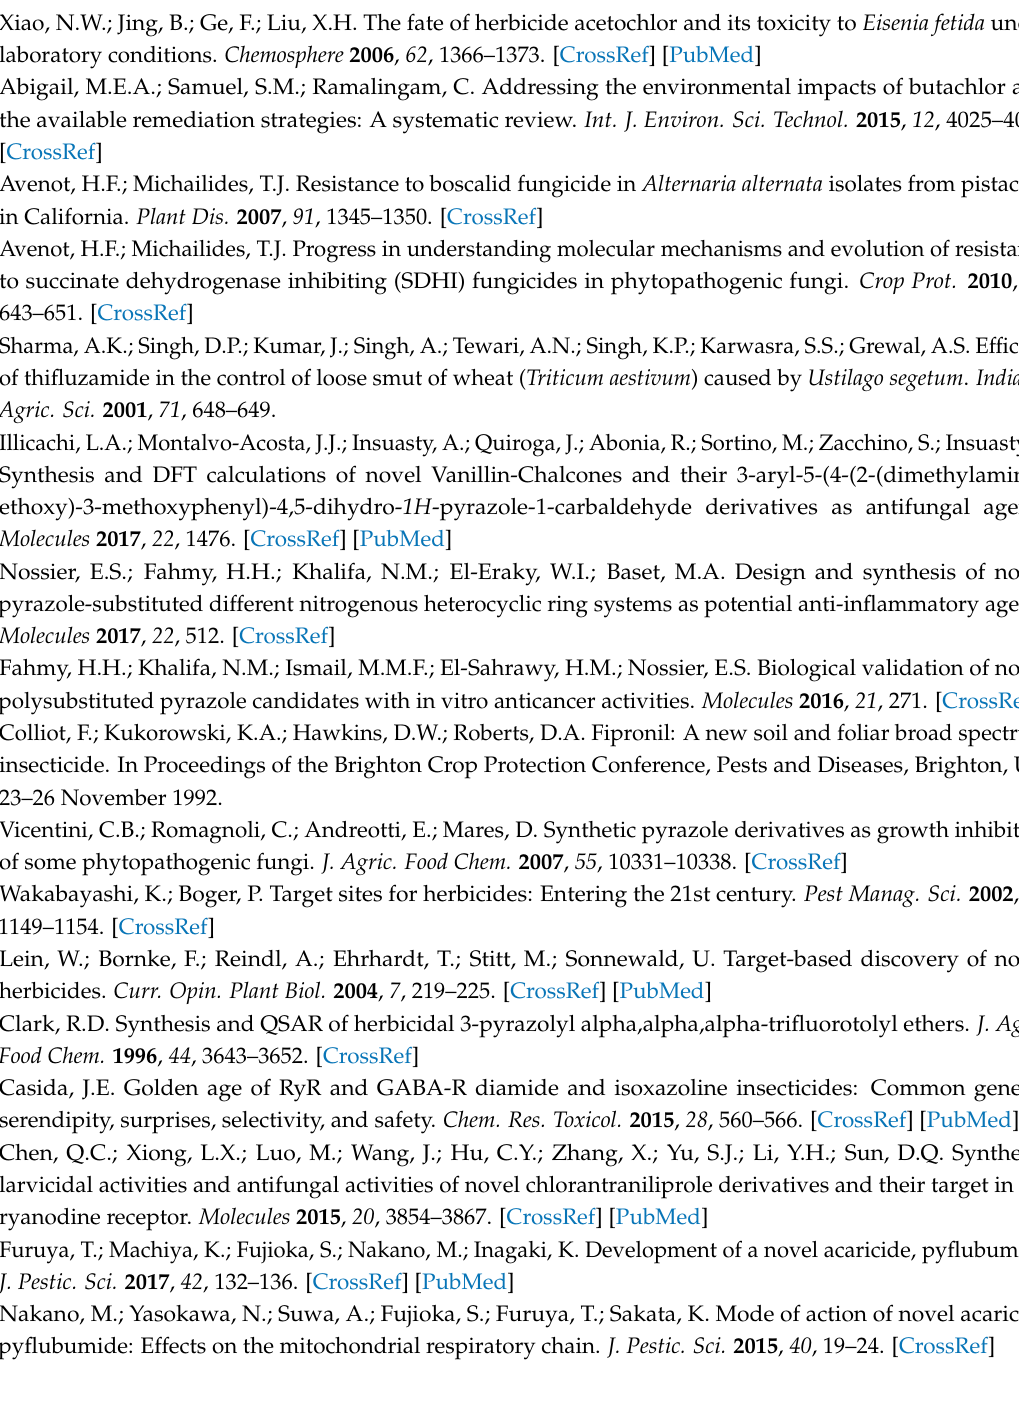
Supplementary Materials: The spectra of 1 H-NMR, 13 C-NMR, and HRMS for all the synthesized compounds are available